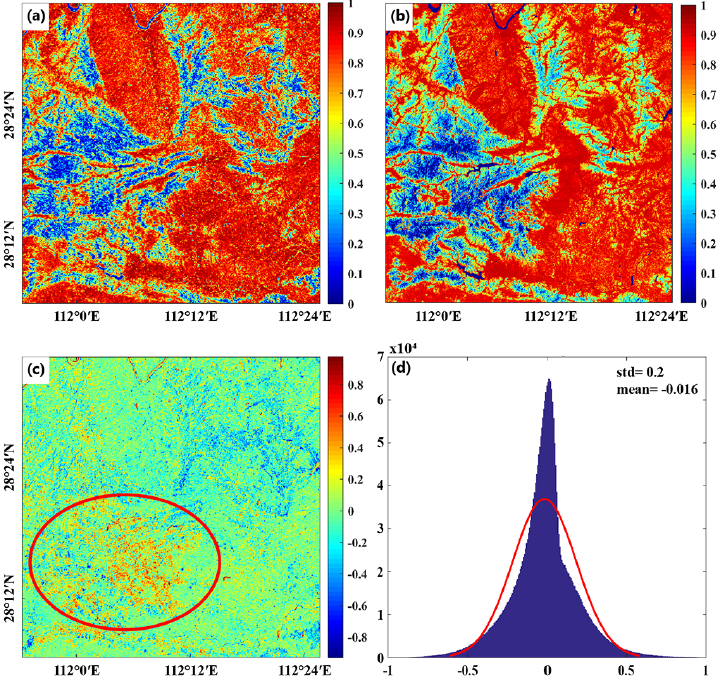
Figure 5. ( a ) True coherence in Meitanba area. ( b ) Estimated coherence by the model in Meitanba area. ( c ) Differences between the true and estimated coherences. ( d ) Histogram of the differences.